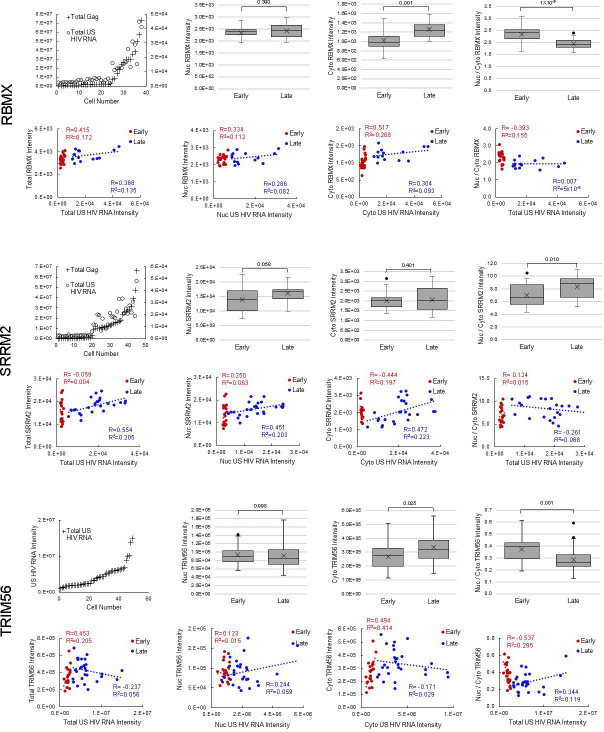
Host protein expression and cellular distribution.